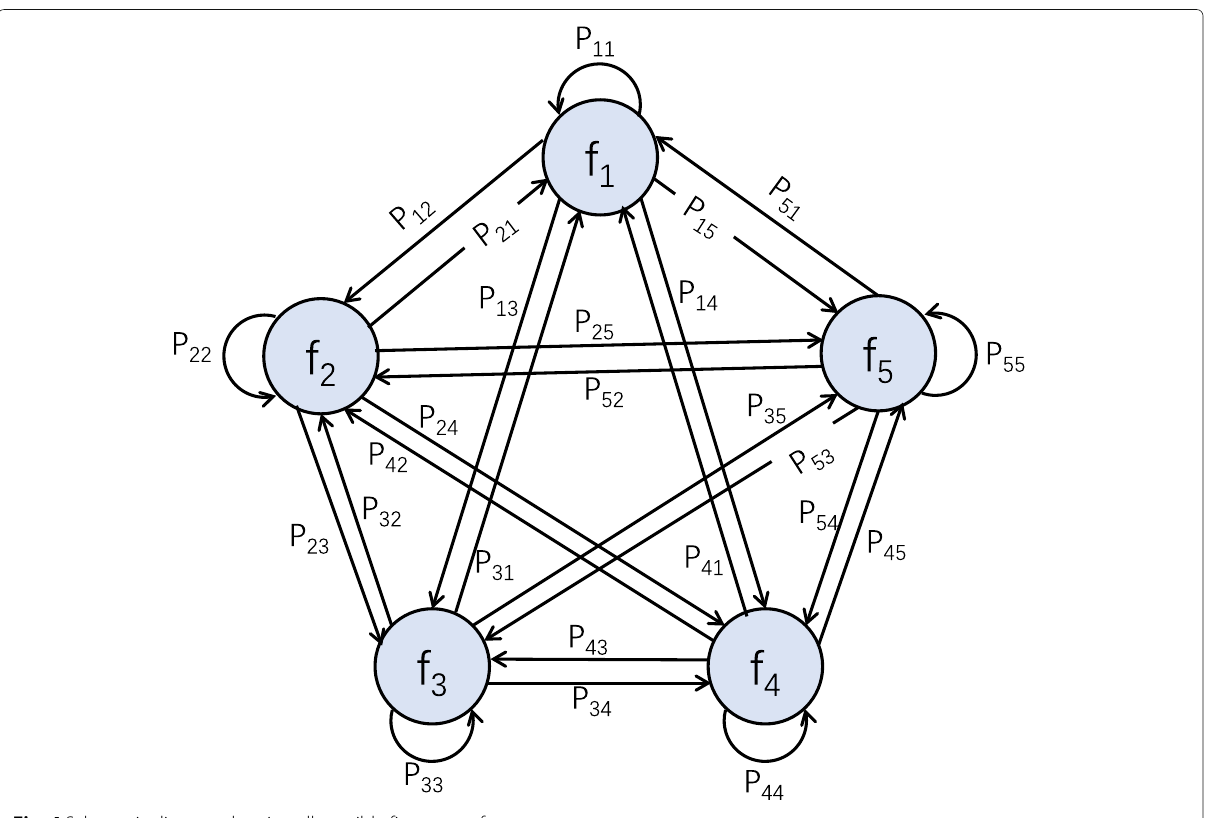
Fig. 4 Schematic diagram showing all possible finger transfers